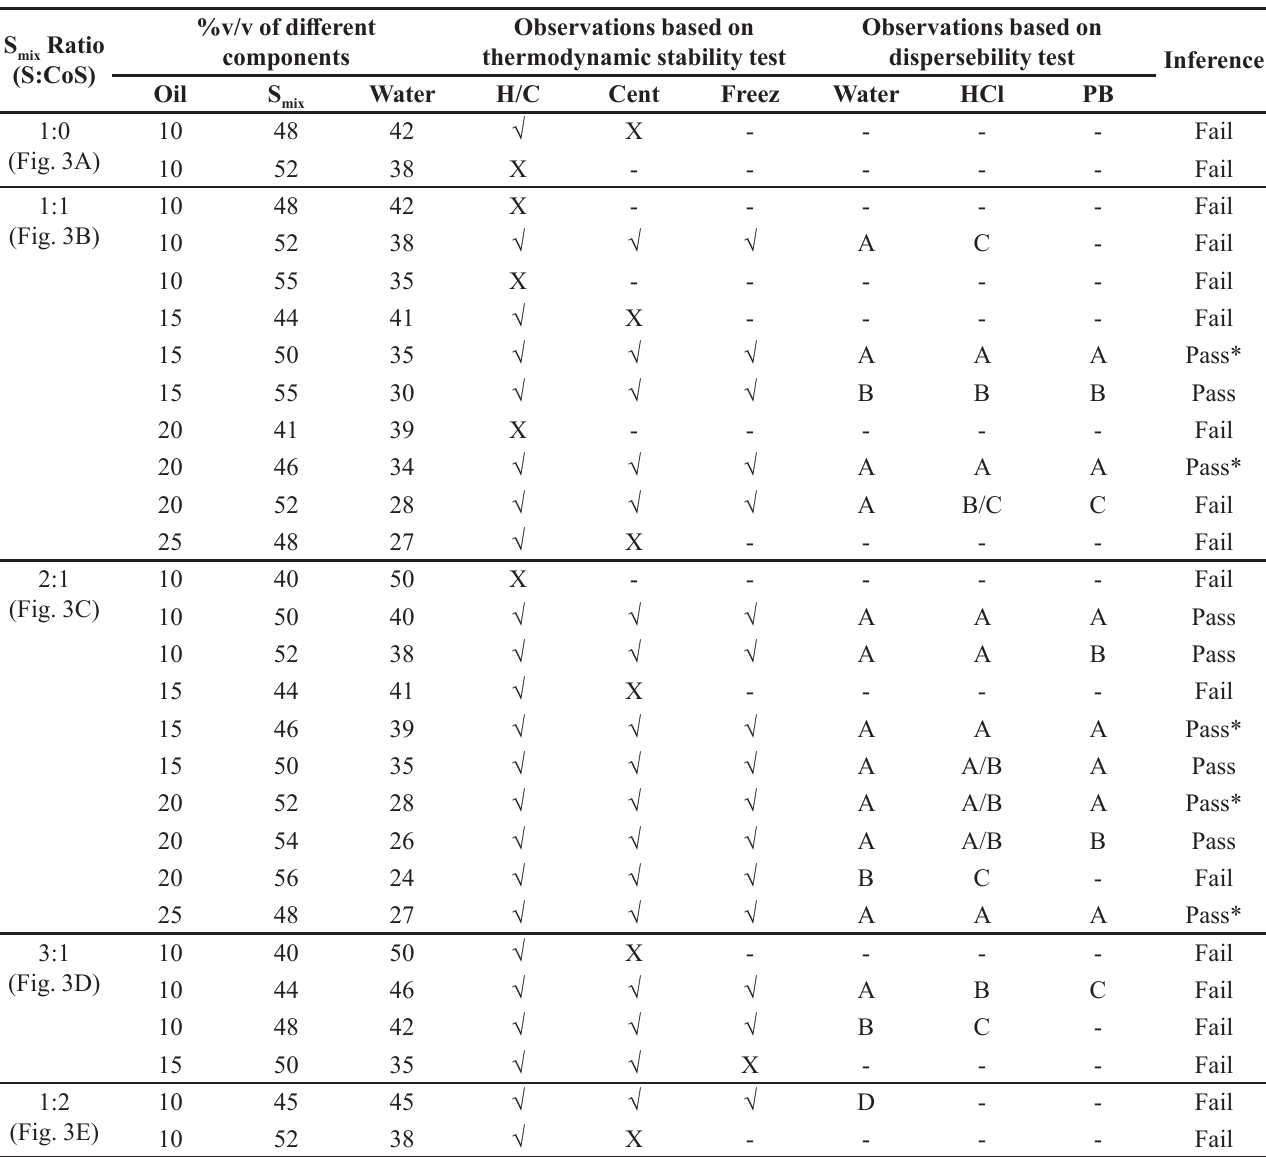
TABLE III - Thermodynamic and dispersibility test of formulations selected from Group I at a difference of 5% v/v of oil S mix